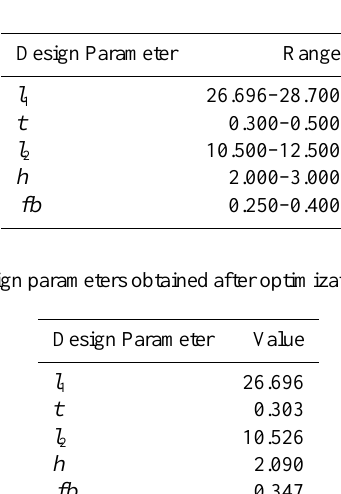
Table 6. Optimized dynamic and static analysis results.